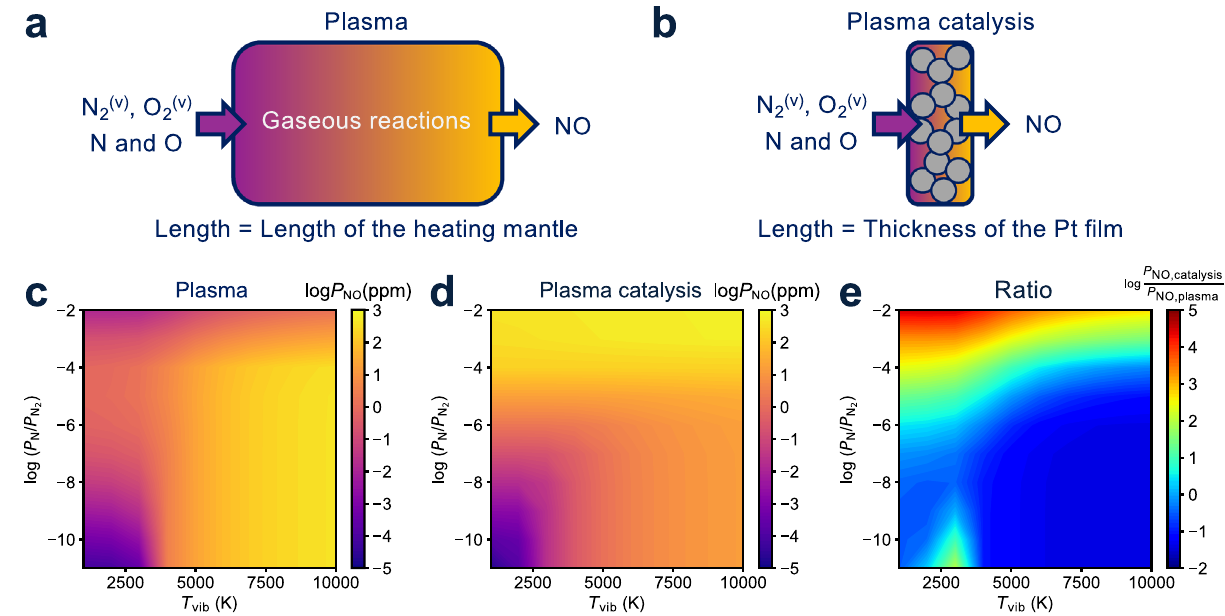
Fig. 4 Plasma vs plasma-catalytic NO production. Schematic representations of integral reactor models for ( a ) plasma reactions and ( b ) plasma catalytic reactions, respectively. Outlet NO concentrations (ppm) of ( c ) plasma reactions and ( d ) plasma catalytic reactions against T vib and P N at 873 K, where the inlet pressures of N 2 and O 2 are 4.995 and 0.005 mbar, respectively. The residence times are 0.28 s and 6.4 μ s in ( a ) and ( b ), respectively. The number of active Pt sites is 230 nmol. e The ratio of NO produced in ( d ) and ( c